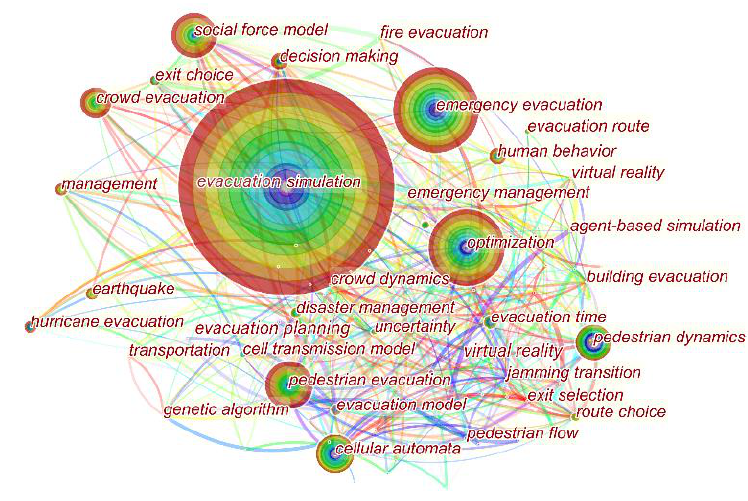
Figure 6. Science mapping of keywords.